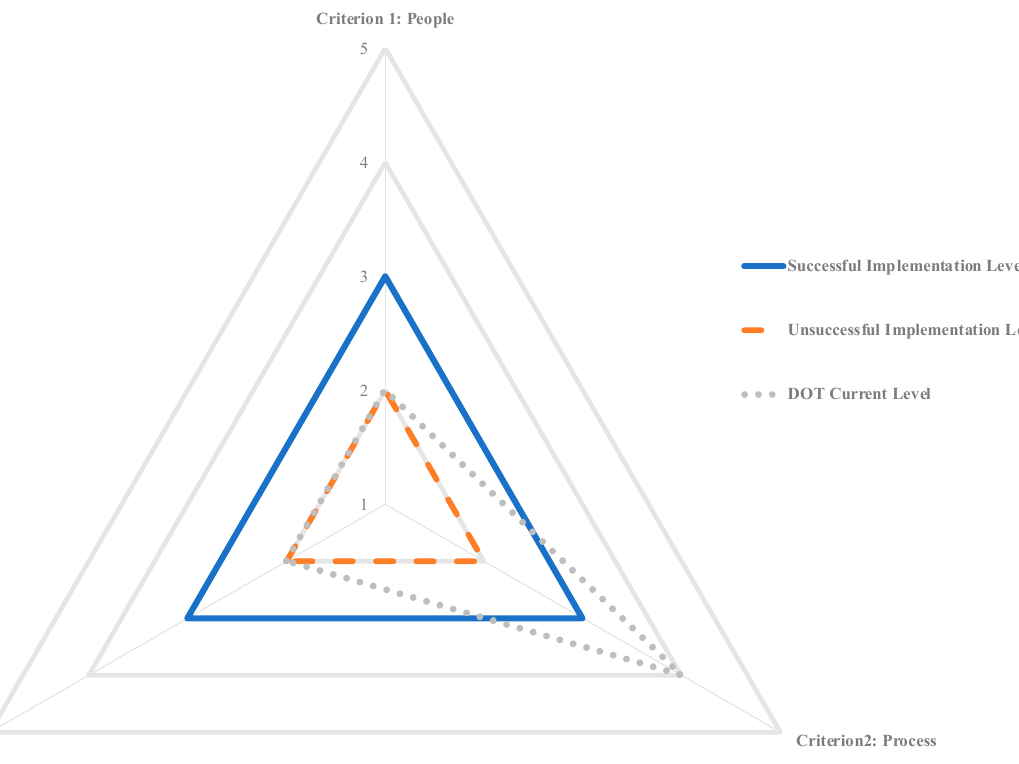
Figure 5. DOT current level, successful, and unsuccessful technology implementation levels visual- ization.